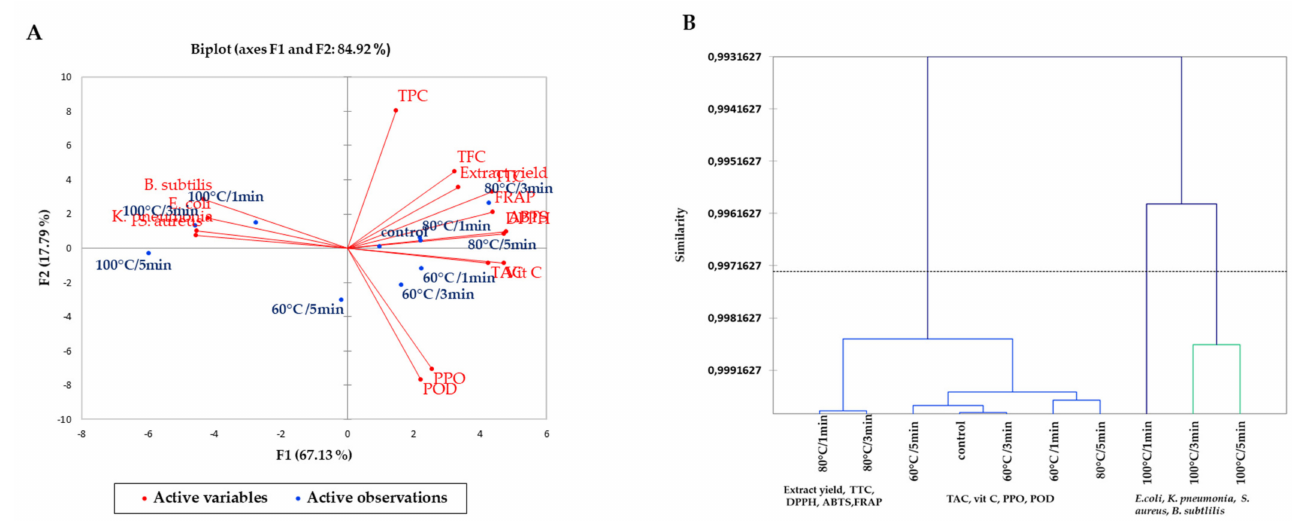
Figure 1. ( A ) Principal component analysis and ( B ) agglomerative hierarchical clustering (AHC) representing blanched ’Wonderful’ pomegranate peel extracts blanched at 60, 80 and 100 ◦ C for 1, 3 and 5 min, and the control shows unblanched peel extracts. TPC, TTC, TFC, TAC, Vit C, DPPH, FRAP, ABTS, PPO and POD represent total phenolic content, total tannin content, total flavonoid content, total anthocyanin content, vitamin C concentration, 2,2 diphenyl-1-picryl hydrazyl assay, ferric-reducing antioxidant power assay and 2,2-azino-bis(3-ethylbenzothiazoline-6-sulphonic acid) assay, polyphenol oxidase and peroxidase,